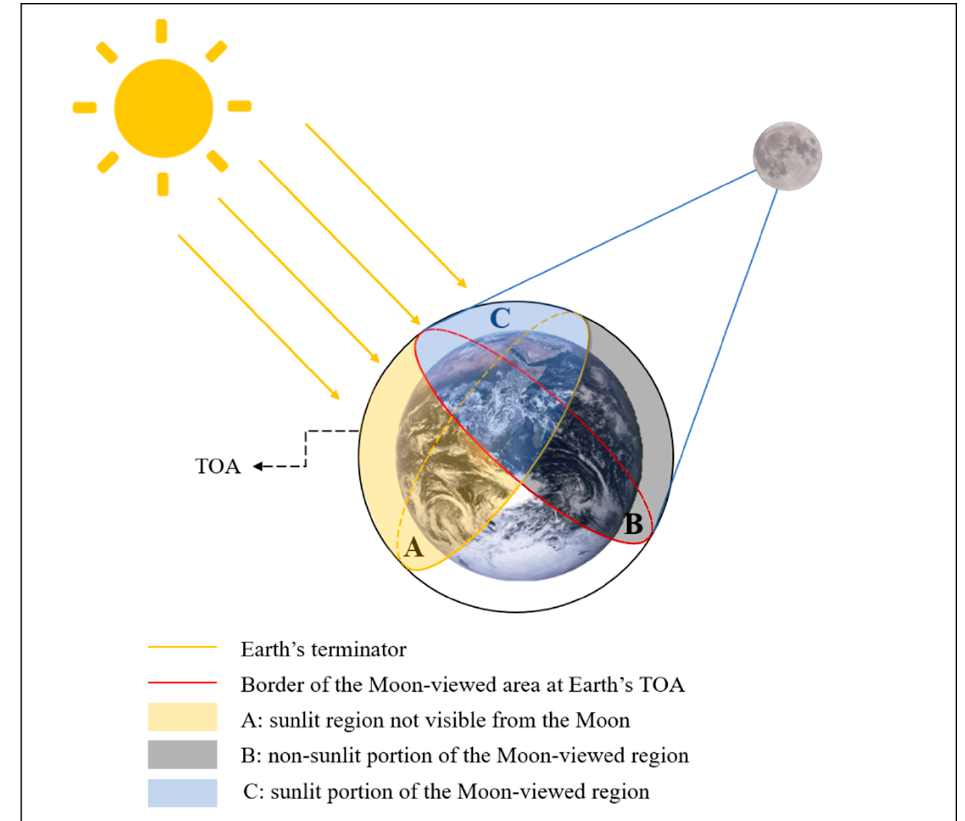
Figure 2. Illustration of the sunlit portions of the Moon-viewed region.